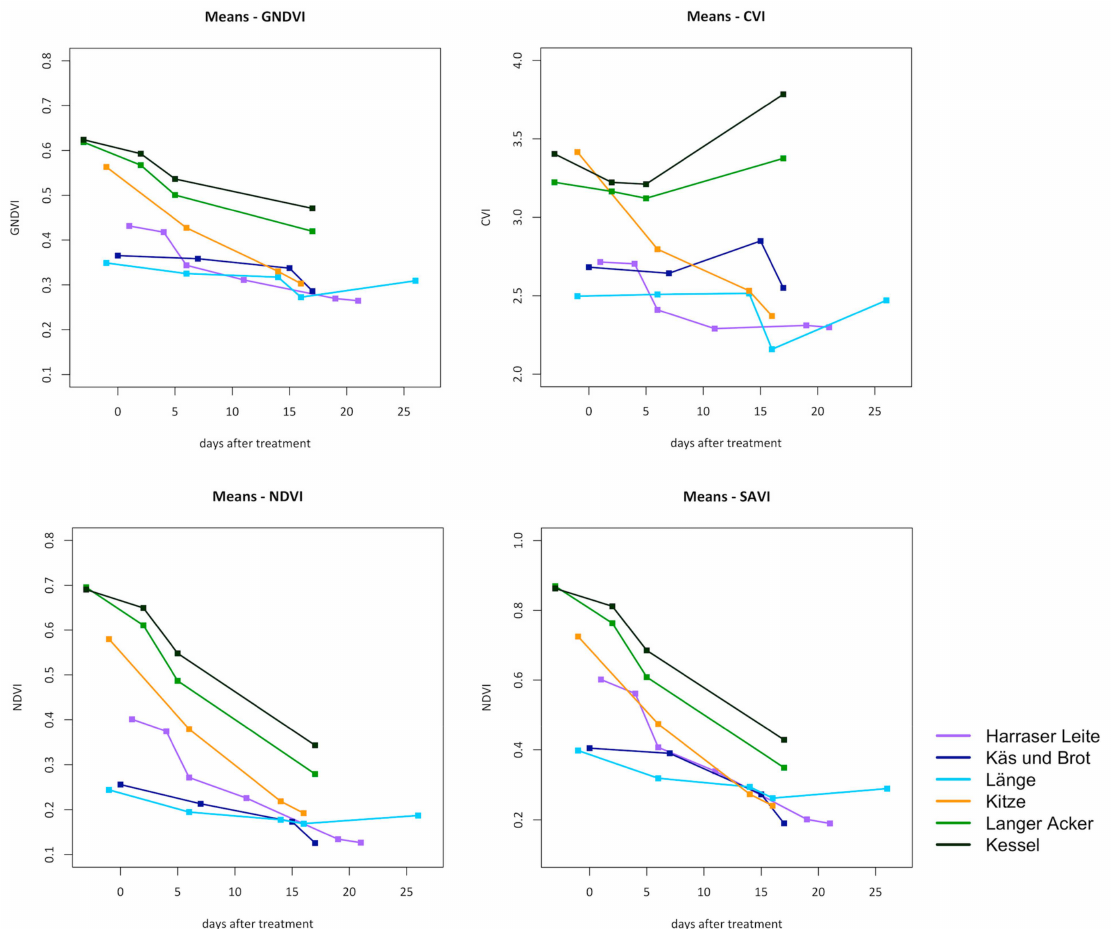
Figure 2. Temporal dynamic of spectral vegetation indices for the test sites. The x-axes represent the number of days after GBH treatment. Day 0 is the day of GBH treatment. The y-axes represent the mean value of the spectral vegetation index of the appropriate study site, i.e., Green Normalized Di ff erence Vegetation Index (GNDVI), Chlorophyll Vegetation Index (CVI), Normalized Di ff erence Vegetation Index (NVDI), Soil Adjusted Vegetation Index